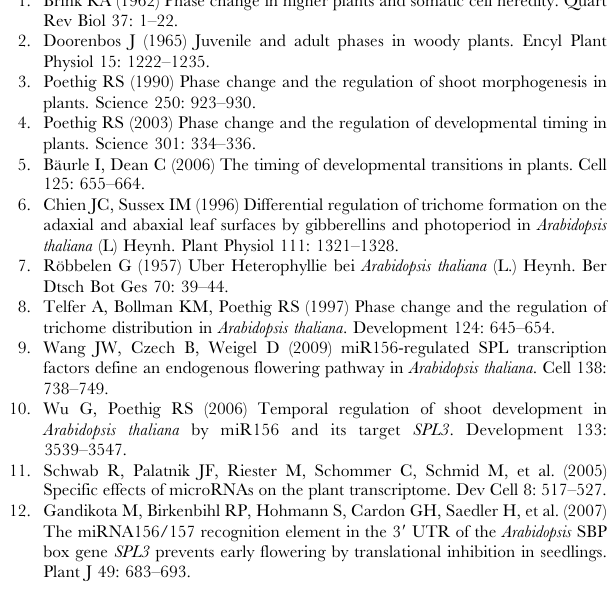
Figure S2 The phenotype of wild-type and transgenic 35S::GUS plants.